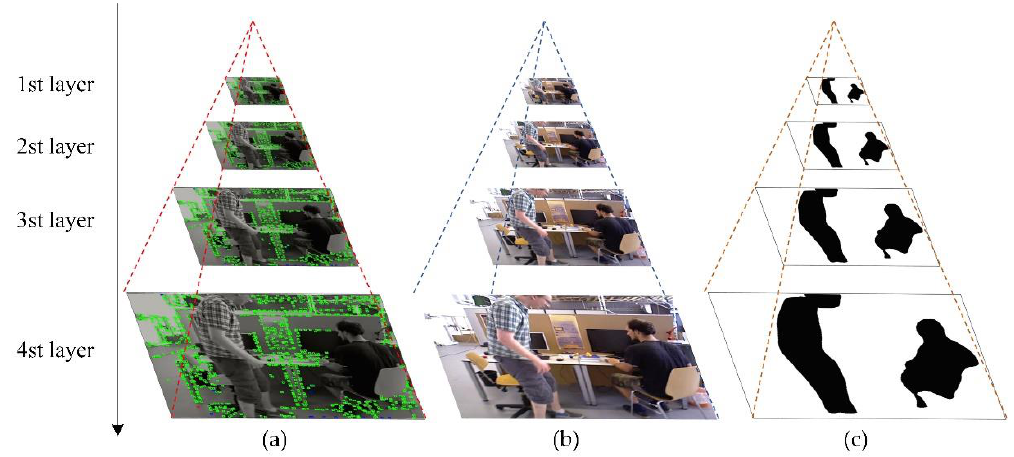
Figure 6. ( a , b ) show the image pyramids constructed by the keyframe and subsequent frame. ( c ) shows Figure 6. ( a ) and ( b ) show the image pyramids constructed by the keyframe and subsequent frame. the semantic image of each layer in subsequent frame ( c ) shows the semantic image of each layer in subsequent frame pyramid.